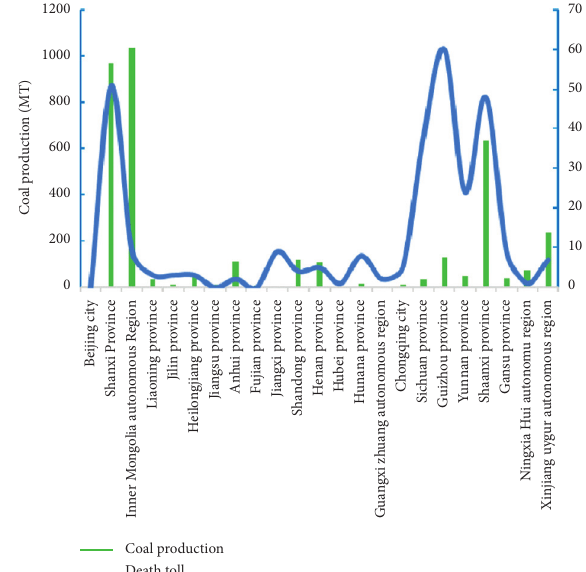
Figure 1: Coal production and death toll statistics for 23 provinces in Figure 5. Because the two sets of data for the throw distance